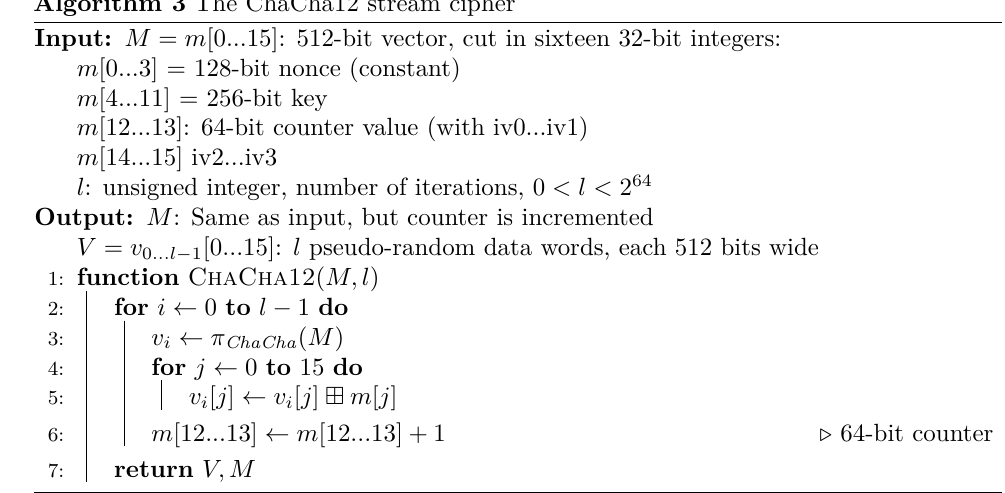
Algorithm 3 The ChaCha12 stream